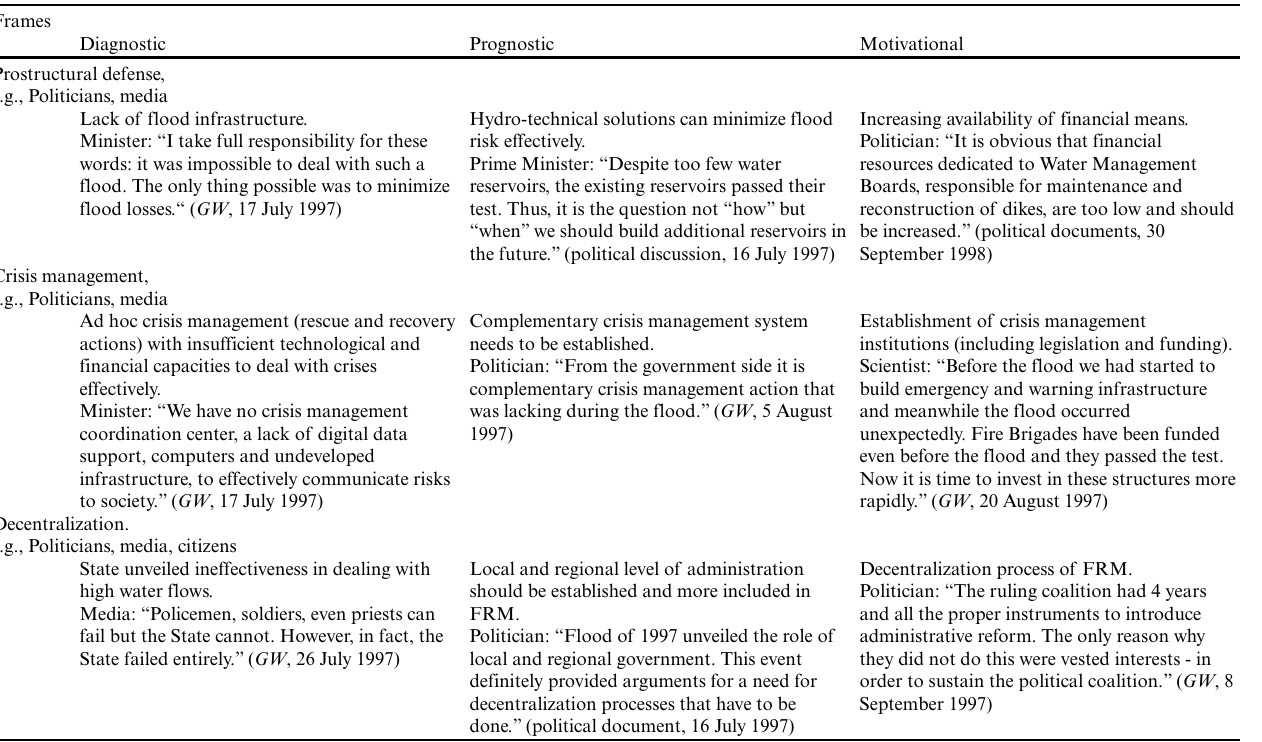
Table 8 . Overview of frames identified after the flood of 1997 with representative quotations. FRM = flood risk management.